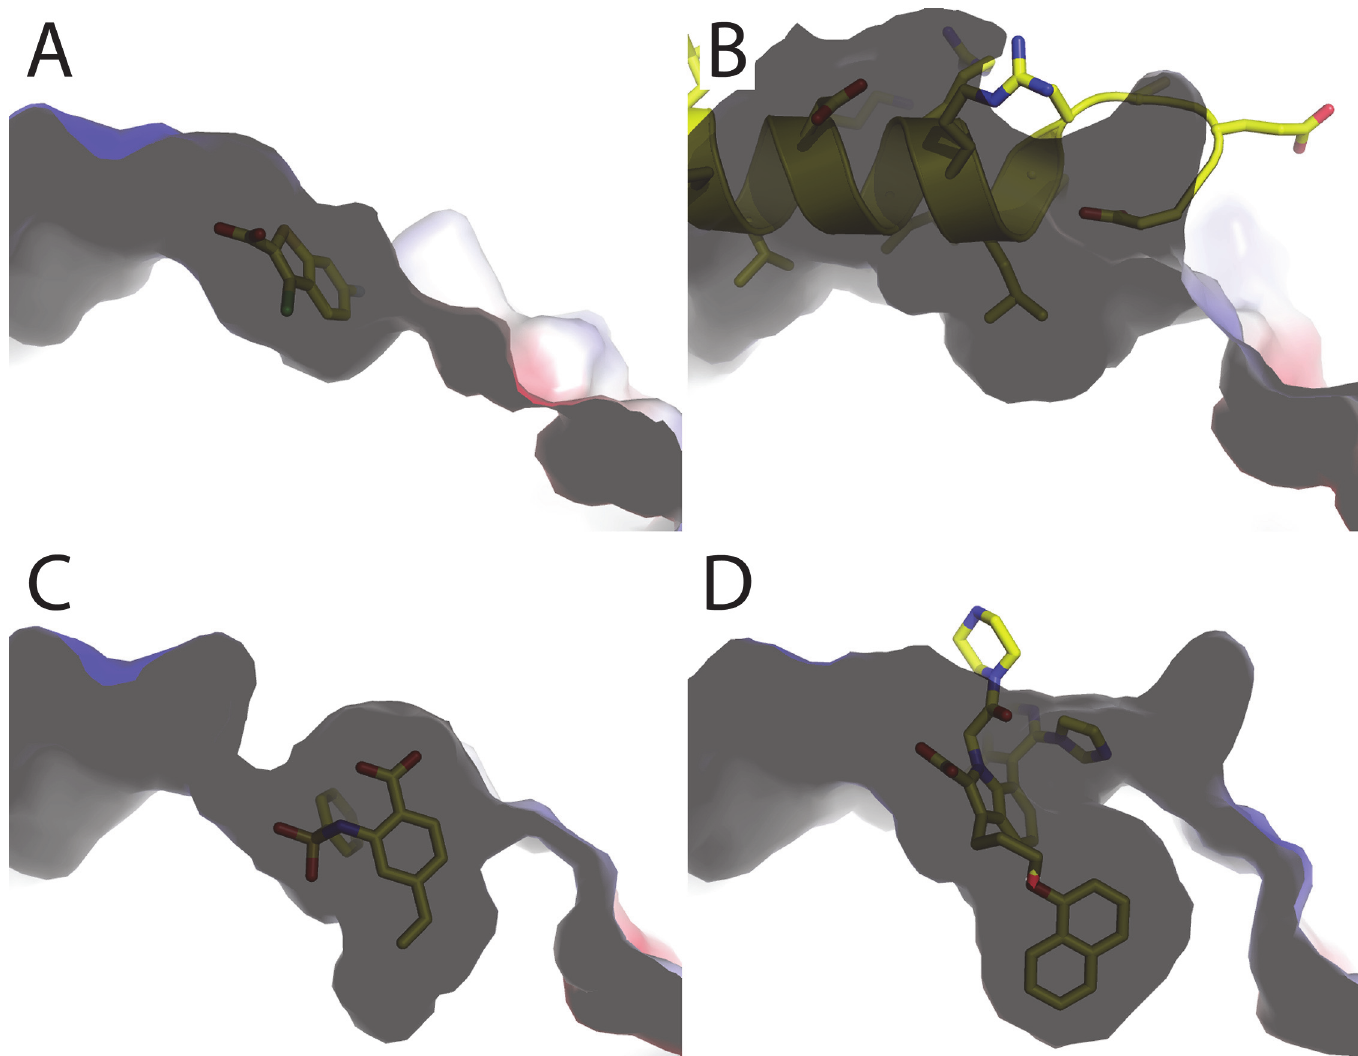
Fig 9. The conformational flexibility of the binding pocket of MCL1. Surface representations are shown as side views and ligands are shown as yellow sticks. (A and B) Fragment 4 maps onto L78 of NoxaB from PDB ID 2NLA, with only minor structural perturbation of the BH3-binding groove of MCL1. In contrast, binding of fragment 6 creates a significant pocket (C) which is further expanded upon binding of ligand 1